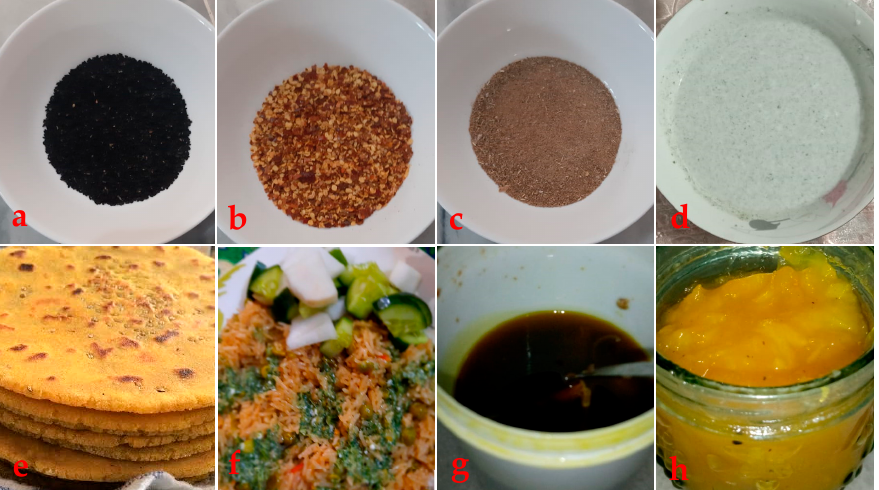
Figure 5. Traditional culinary uses of wild food plants by different linguistic and religious communities reported from the study area: ( a ) mixture of black pepper and Mentha royleana ; ( b ) mixture of chilies and Mentha pulegium ; ( c ) powdered Citrullus colocynthis ; ( d ) powedered Mentha arvensis in yogurt; ( e ) bread made with rice flour with Opuntia dillenii pulp; ( f ) rice cooked with Amaranthus viridis seeds and Cucumis melo as salad; ( g ) herbal drink made with Cannabis sativa ; ( h ) jam made by Prosopis cineraria fruits.